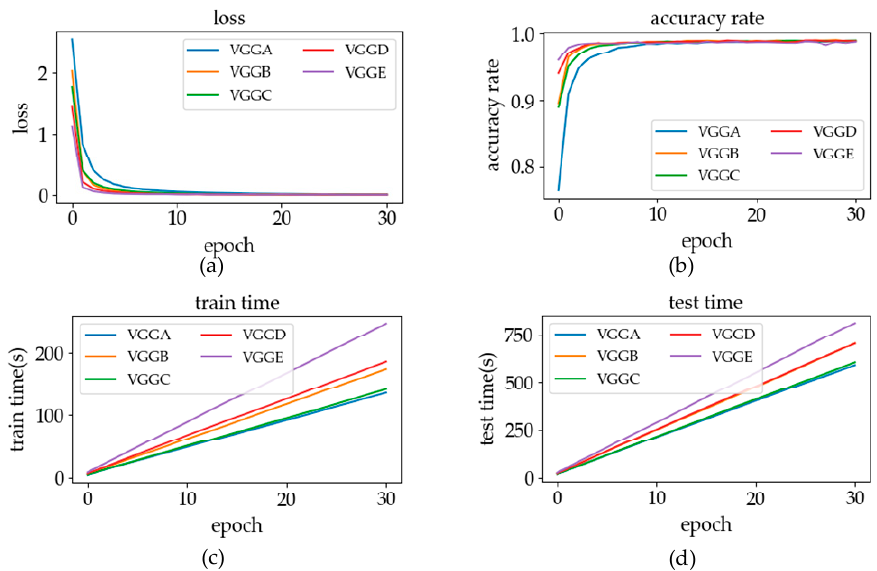
Figure 17. Experimental results demonstration of the convolutional network structure. The graphs show the changes of the five network structures with an epoch under one certain assessment index with epochs during the training process. Each epoch contained 601 iterative updates of the network parameters. ( a ) The change curve of loss with epoch; ( b ) the change curve of the accuracy rate with epoch; ( c ) the change curve of training time with epoch; ( d ) the change curve of test time with epoch.